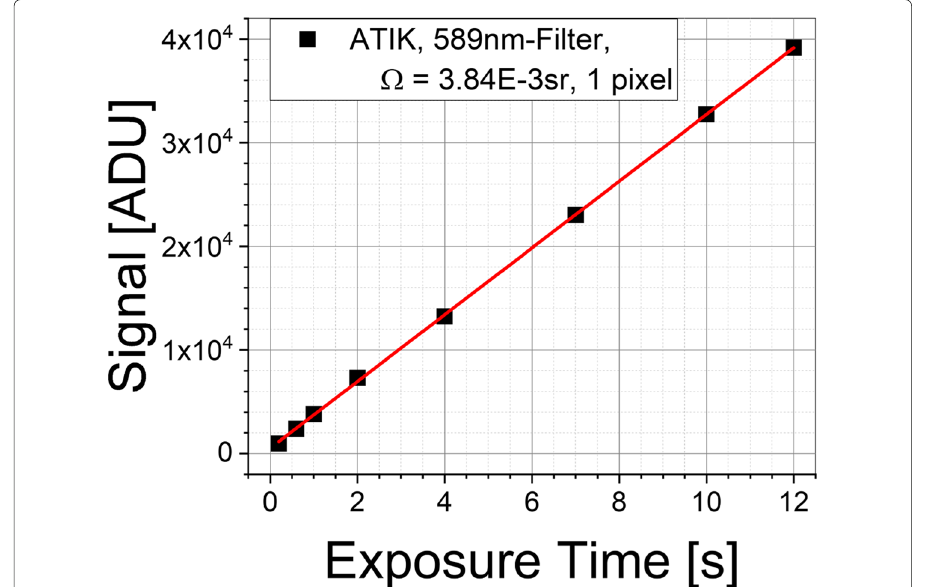
Fig. 4 The grey value (in Bits) is shown versus the exposure time as an example using the bandpass filter with a center wavelength (CWL) of 589nm. It shows the linear behavior of the camera with respect to exposure time. All three cameras show the same linear behavior with all bandpass filters